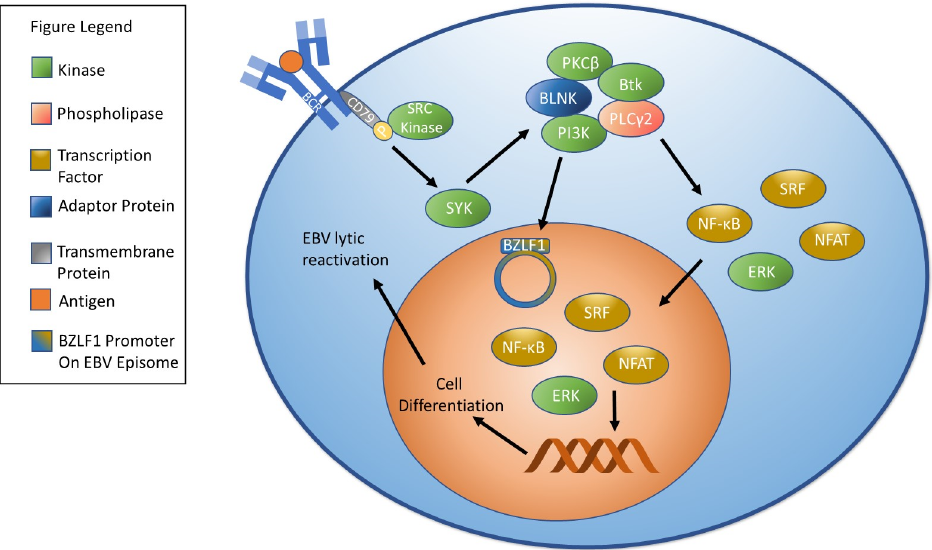
Figure 2. B Cell Receptor Signaling and EBV Reactivation. B cell receptor signaling begins when an antigen binds to the B cell receptor. Binding causes SRC kinases to phosphorylate CD 79, which stimulates SYK. SYK stimulation results in the formation of a signalosome comprised of PI3K, Btk, BLNK, PLC γ 2, and PKC β . Signalosome activation results in the activation of molecules that influence gene expression including NF- κ B, NFAT, ERK, and SRF. Stimulation of the B cell receptor leads to plasma cell differentiation and can trigger EBV reactivation. Notably, activation of PI3K has been shown to stimulate EBV reactivation.